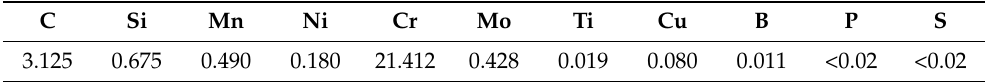
Table 1. Chemical composition of the HCCI